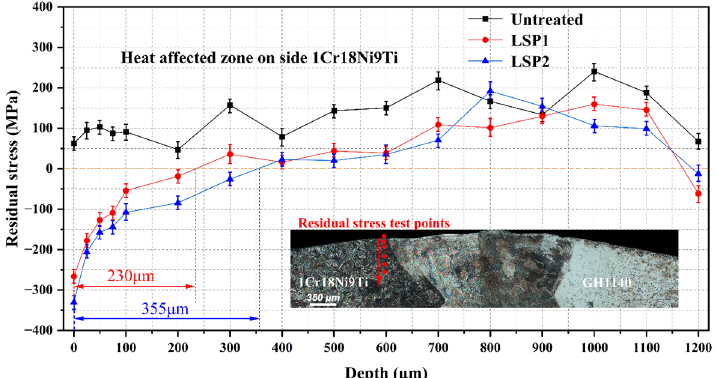
Figure 3. Residual stress distribution on weld surface of combustion liner.